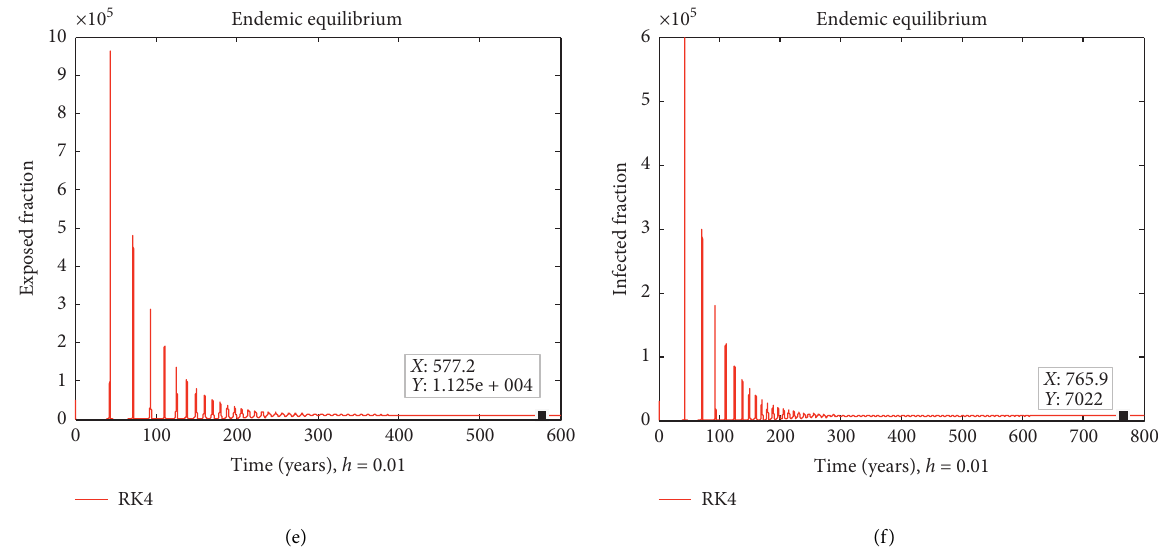
Figure 5: Time plots of susceptible, exposed, and infected population using the RK-4 method with h � 0 . 01 .